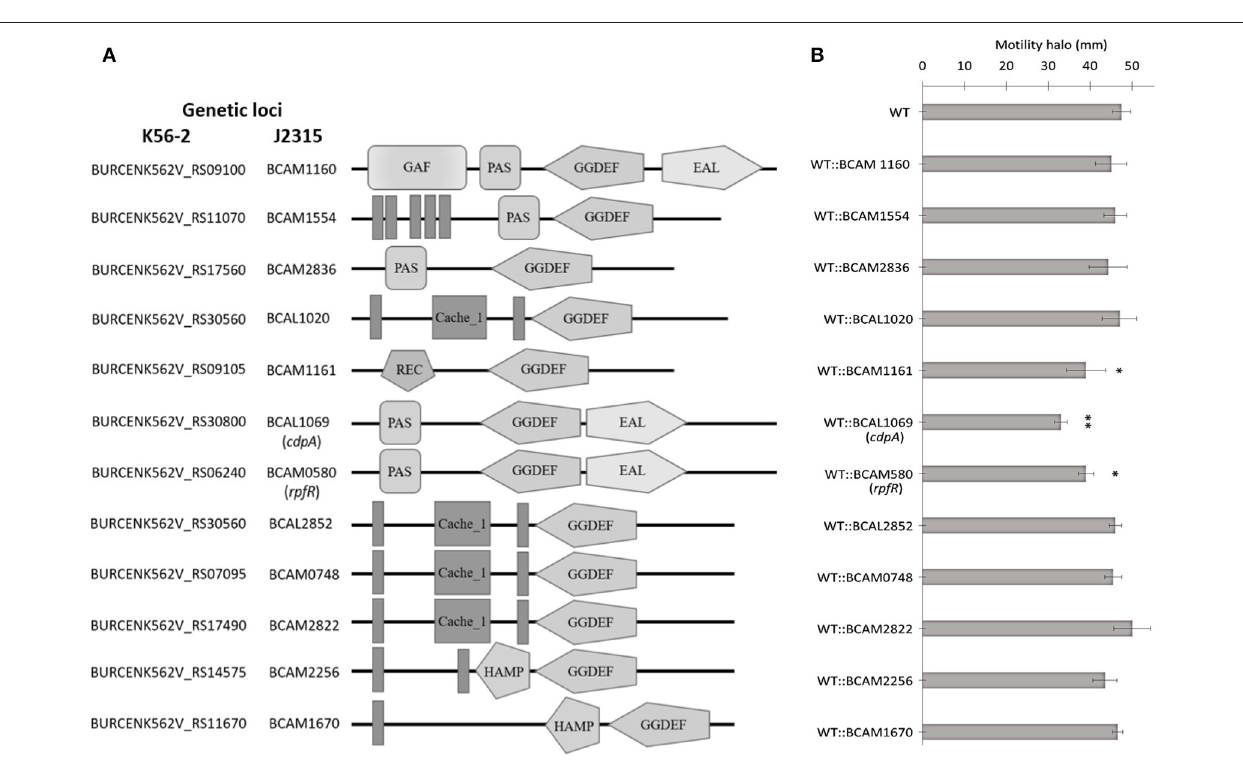
( rpfR ) and WT::BCAL1069 ( cdpA ) mutants exhibited a